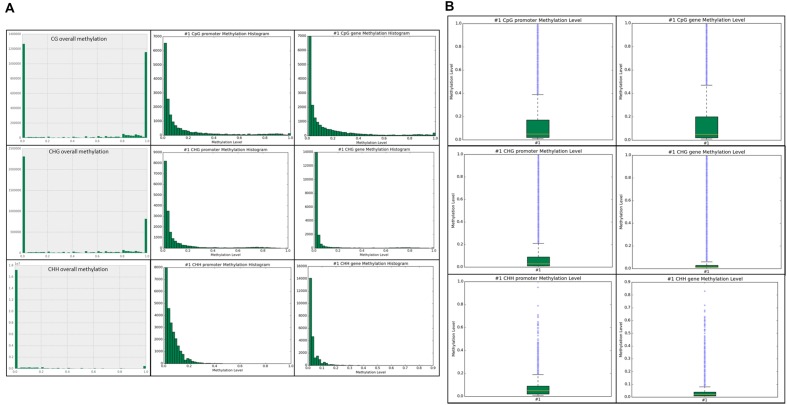
(A) Unique sites detected for each context sequence is shown. The top row is the CG overall methylation throughout the genome, followed by CG promoter methylation, and CG gene methylation. The middle row is CHG overall, promoter, and gene methylation. The bottom row is CHH overall, promoter, and gene methylation. The x-axis is methylation level in 0.1 intervals, ranging from 0.0–1.0. The y-axis is the frequency of the particular methylation level in that context in the associated genomic feature. (B) Boxplots of promoter and genic methylation levels are shown on a scale of 0.0–1.0.